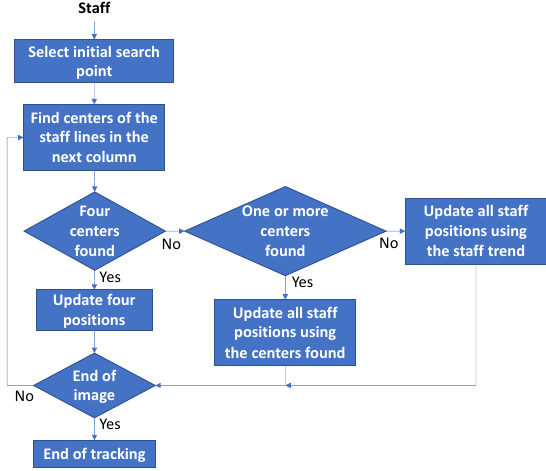
Figure 6. Simplified diagram of the staff tracking